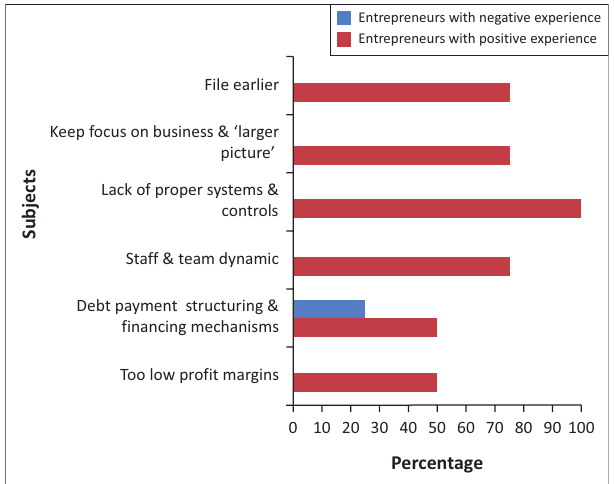
FIGURE 3: Relative indication of business-related learning content dimensions identified by subjects.